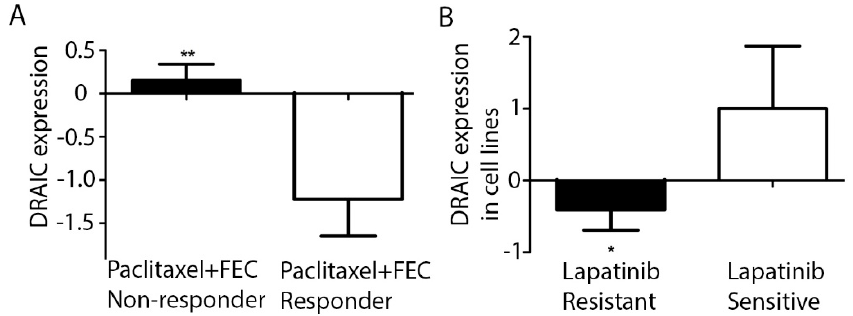
Figure 4. DRAIC expression correlates to chemotherapy treatment response. ( A ) DRAIC expression in 88 paclitaxel and FEC (fluorouracil/epirubicin/cyclophosphamide) non-responder patients and 27 paclitaxel and FEC responder patients’ samples (Miyake 2012) were shown as mean ± SEM. ( B ) DRAIC expression in 17 lapatinib resistant cell lines and 5 sensitive cell lines (Barretina 2012) were shown as mean ± SEM. Statistical significance was calculated by two-tailed student’s t -test, * indicates p < 0.05 and ** indicates p < 0.01.